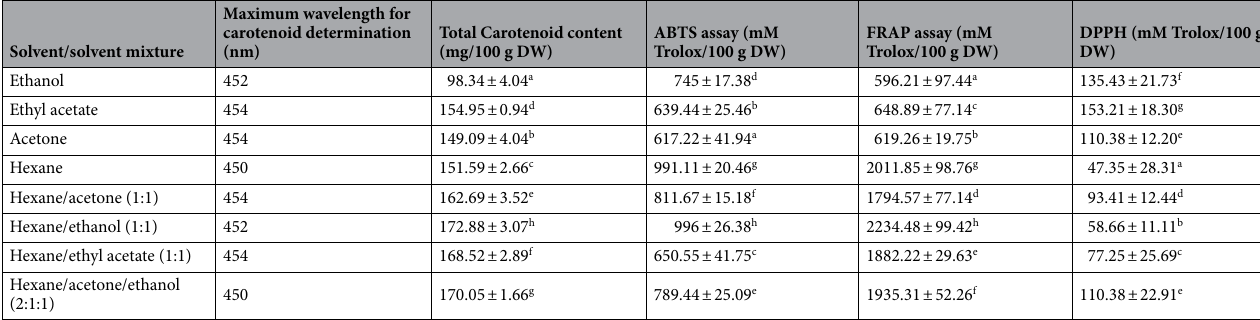
Table 2. Total carotenoids and antioxidant activity of extract obtained from carrot rejects in study 1. Values are presented as mean ± SD of three replicates. Different letters in the same column indicate a statistically significant difference at (p <